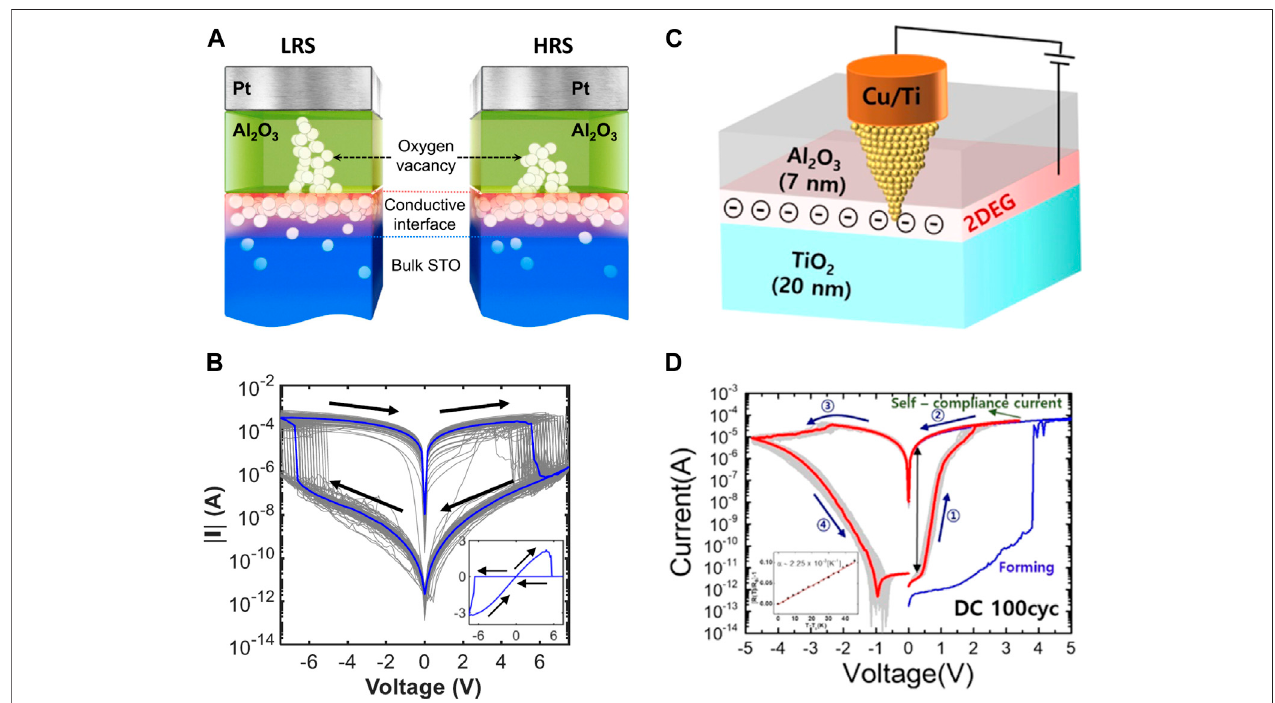
FIGURE 2 | Recent examples of 2DEGs-based RRAM devices. (A) Schematic of a VCM-type RRAM device based on 2DEGs formed between amorphous ALD-Al 2 O 3 and single-crystalline SrTiO 3 (STO) [24]. (C) Schematic of a CBRAM-type RRAM device based on the scalable All-ALD 2DEGs [25]. Panels (B) and (D) both present 100 cycles of consecutive DC current-voltage sweeps of the VCM and CBRAM devices